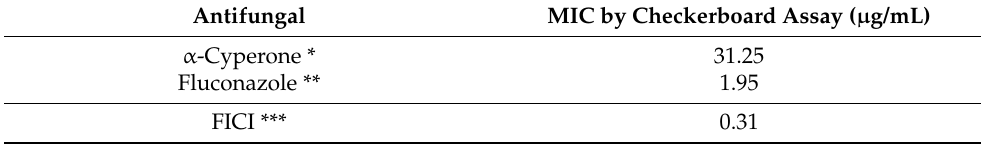
Table 1. Synergistic antifungal activity of α -Cyperone with fluconazole against C. krusei